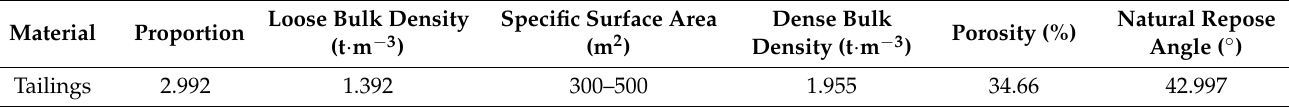
Table 1. Basic physical parameters of tailings.